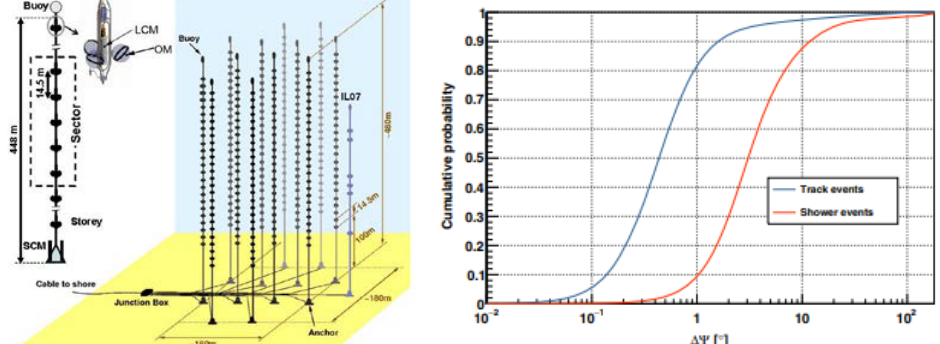
Figure 1. Left : Layout of the ANTARES detector. Right : Angular resolution for the sample of events for point- like source